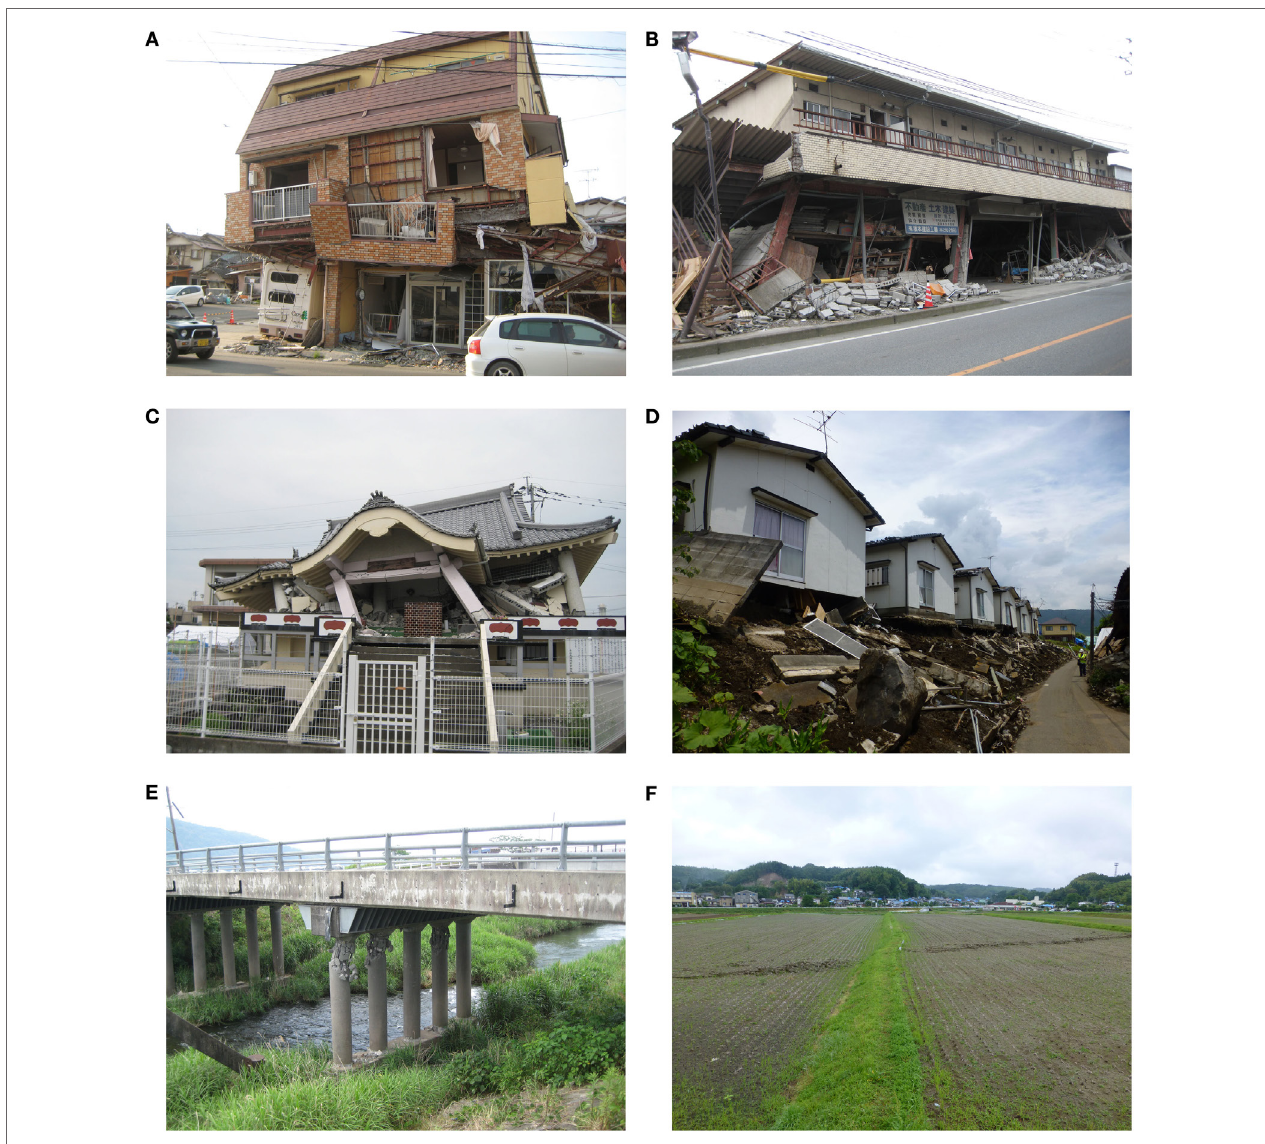
FigUre 13 | (a) Collapsed steel building along Road 28 (location 5 in region 2). (B) Collapsed steel building along road 28 (location 5 in region 2). (c) Collapsed RC temple near the Mashiki town office (location 5 in region 2). (D) Building damage due to foundation failures (location 5 in region 2; near KMMH16). (e) Failures of RC piers of Daiichi Hatanaka bridge (location 5 in region 2). (F) Fault surface rupture (location 6 in region